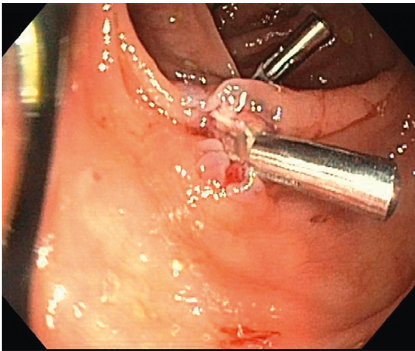
Figure 2: The polyp was removed using snare cautery, and two clips were placed at the polypectomy site to help prevent bleeding.